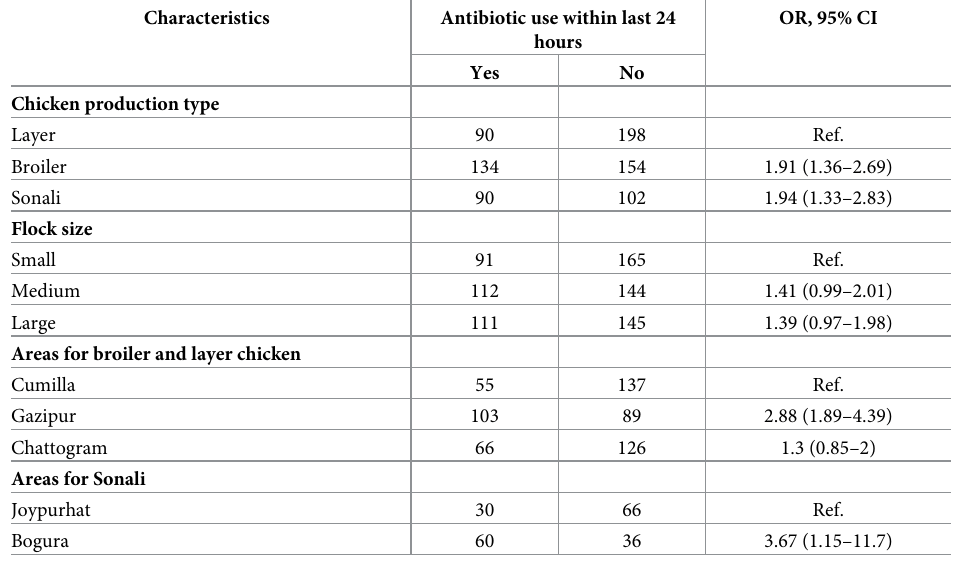
Table 7. Comparison of antibiotic use in commercial chicken farms (N = 768) by production type, flock size and areas, during January-May 2021, Bangladesh.